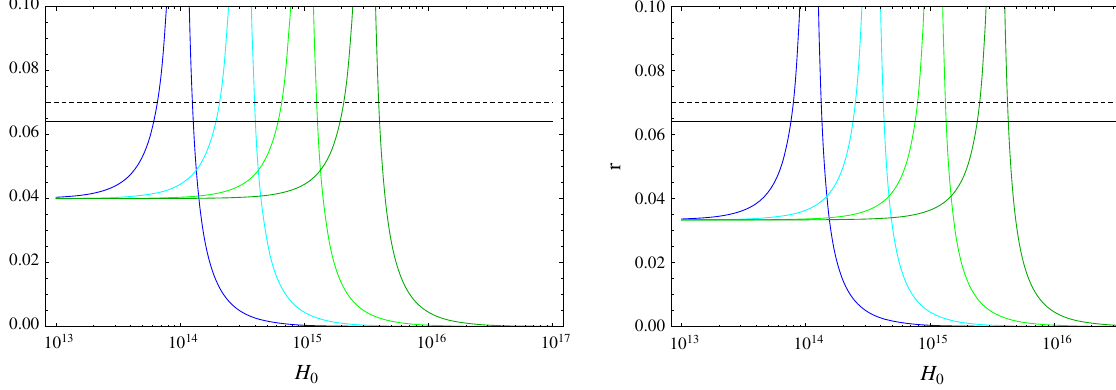
Fig. 4 The tensor-to-scalar ratio with respect to H 0 the left, and to H 1 in the right, for N = 50 and γ = b = 1 and μ = 1s − 1 . The plots are identical for N = 60 and any other values of γ , b and μ . The blue, cyan, green and darker green curves correspond to different values